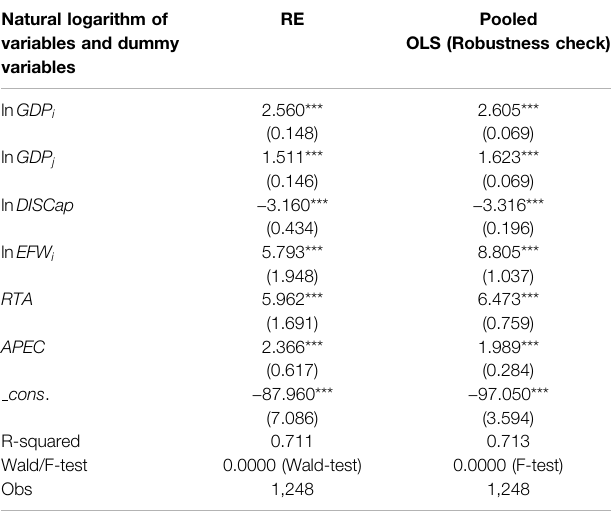
RE Pooled OLS (Robustness check)